Question: How would you classify this visualization?
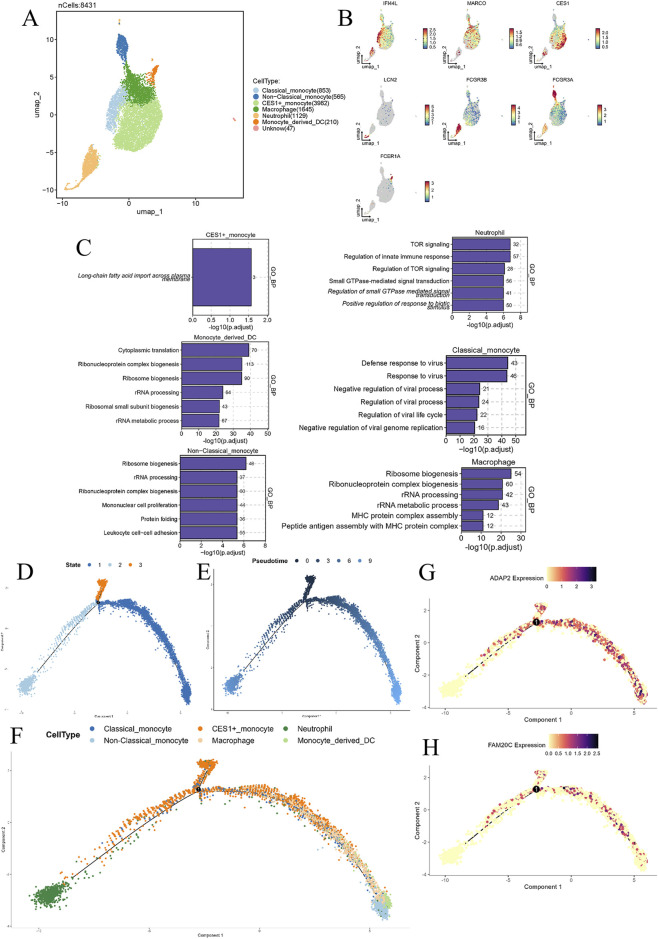
Answer: scatter